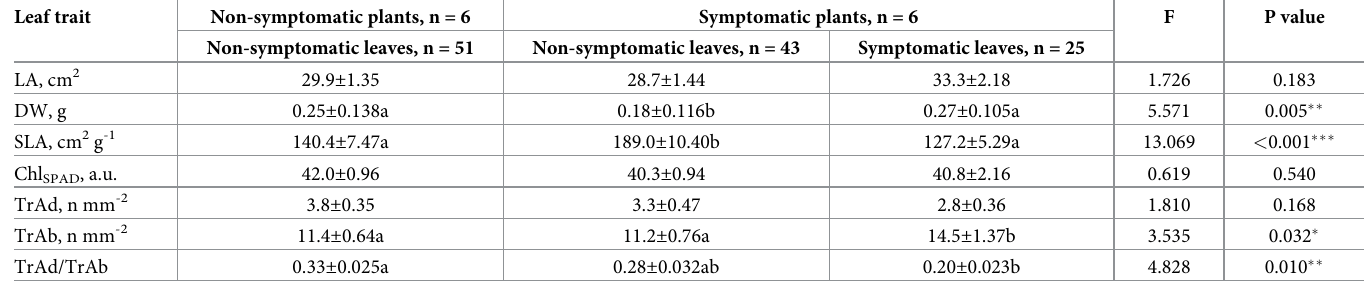
Table 2. Mean values ± S.E. of leaf traits and one-way ANOVA results (F and P value). Letters represent the significant differences after post-hoc Fisher’s LSD test. LA: leaf area; DW: dry weight; SLA: specific leaf area; Chl SPAD : chlorophyll content measured with the chlorophyll meter SPAD; TrAd: adaxial trichomes density; TrAb: abaxial trichomes density; TrAd/TrAb: ratio between adaxial and abaxial trichomes density. Leaf trait